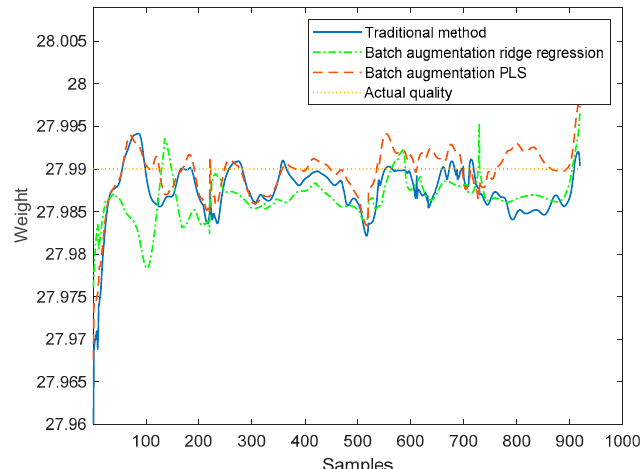
Figure 9. Quality prediction of batch 55.